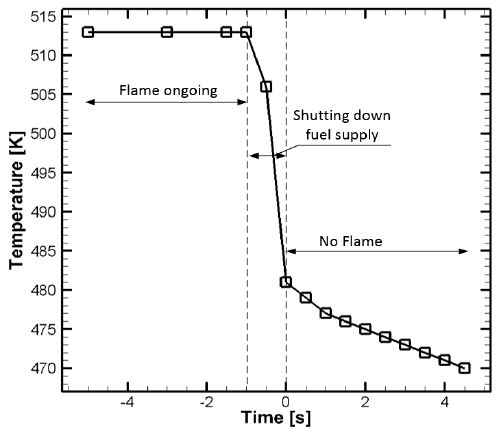
Figure 4. Typical temperature changes of T edge during shutting down the fuel